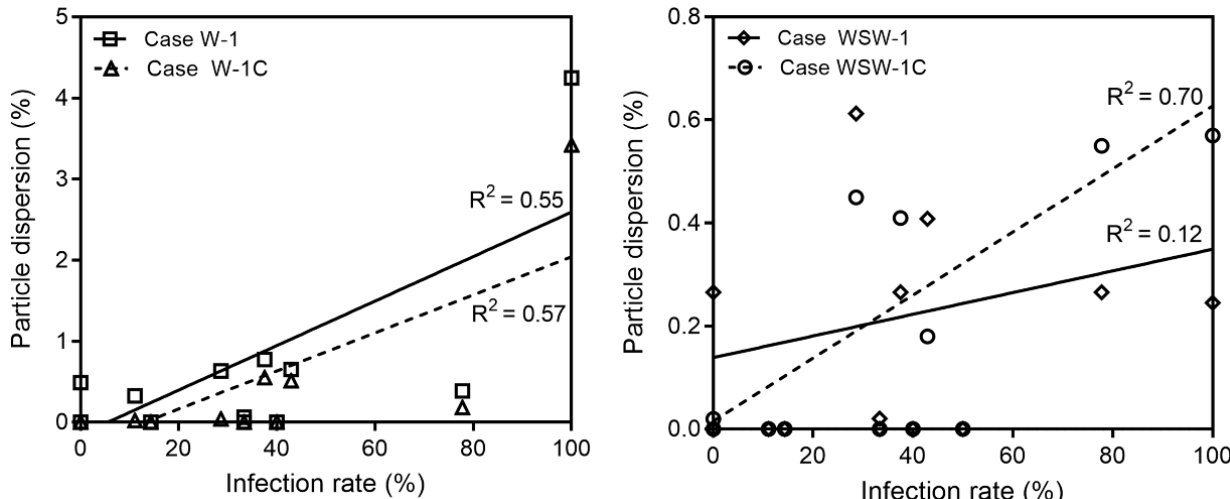
Figure 9. Validation for the accuracy of breathing and coughing